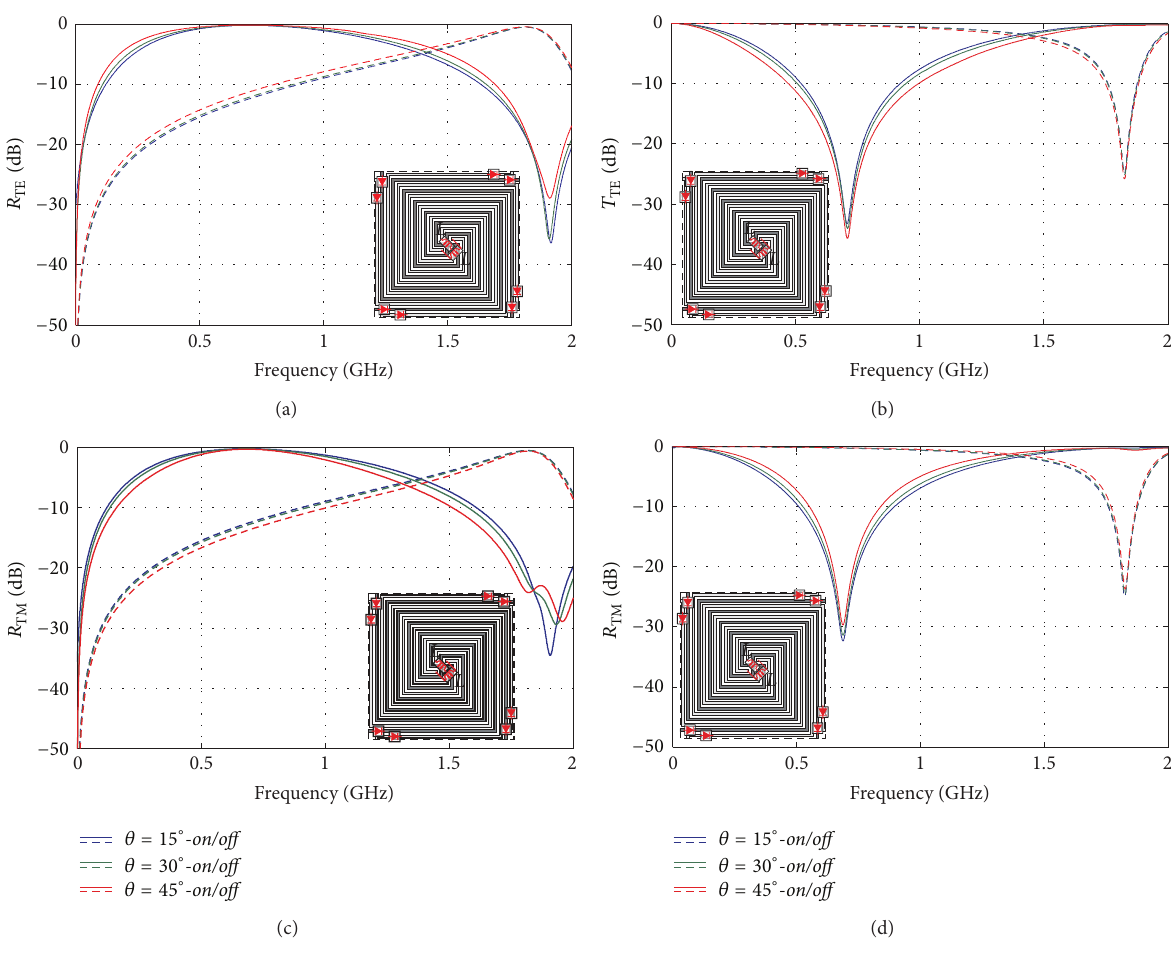
Figure 14: Transmittance and reflectance of the AFSS with the unit cell layout of Figure 8, modified with the introduction of four additional switches, at oblique incidence of TE (a)-(b) and TM (c)-(d) waves when the pin diode switches are in the on (solid lines) and off (dashed lines)